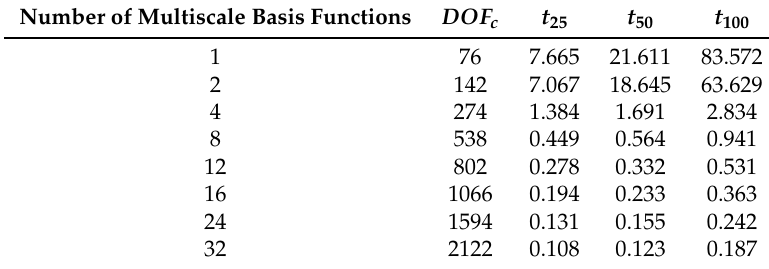
Table 3. Numerical results for Test 1.RBC . Relative L 2 error (%) for different numbers of multiscale basis functions.